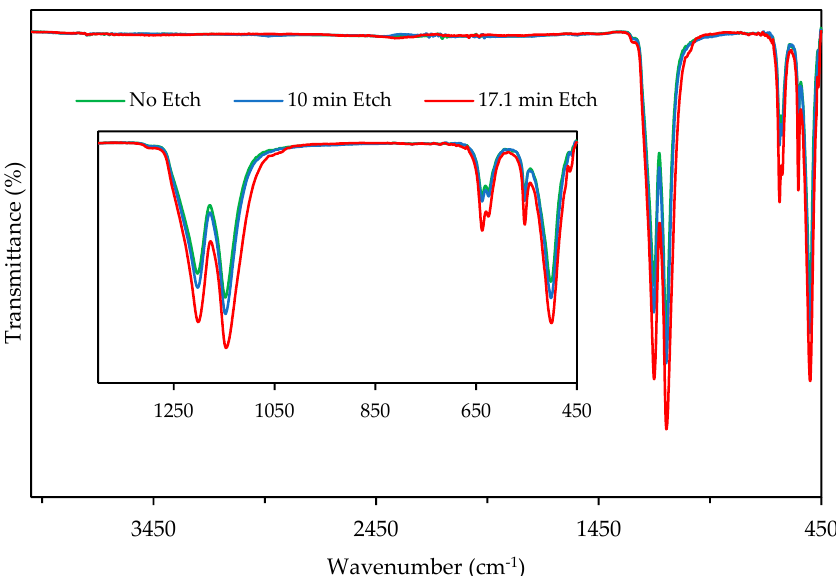
Figure 6. Fourier transform infra-red (FTIR) transmittance of PTFE micro-particles non-etched, 10.0 min etched and 17.1 min etched.